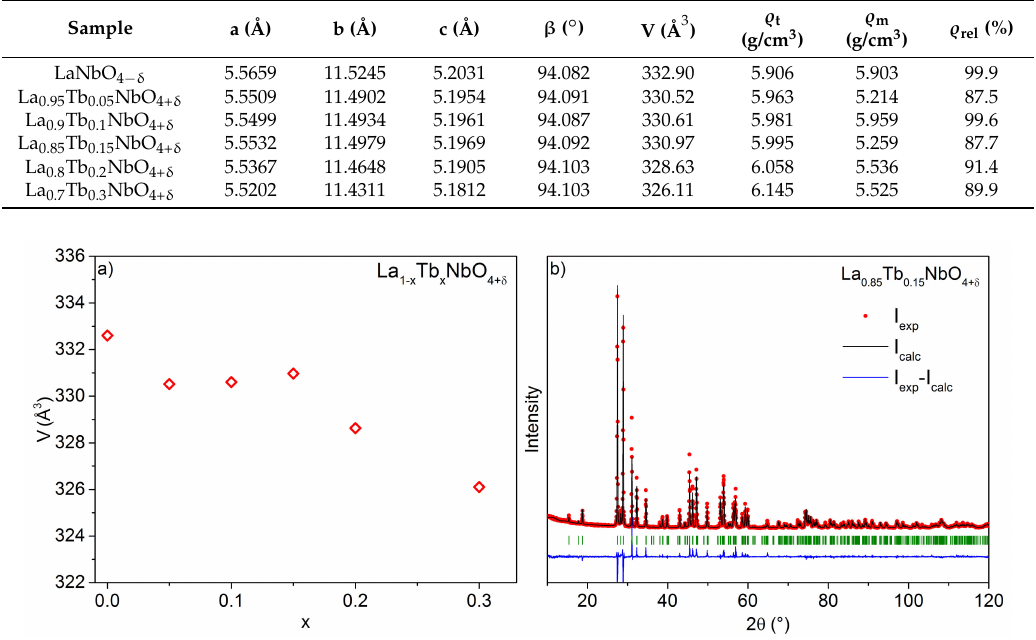
Figure 2. ( a ) Unit cell volume as a function of Tb content in La 1 − x Tb x NbO 4+ δ . ( b ) The Rietveld profile of the pattern and the difference plots for La 0.85 Tb 0.15 NbO 4+ δ